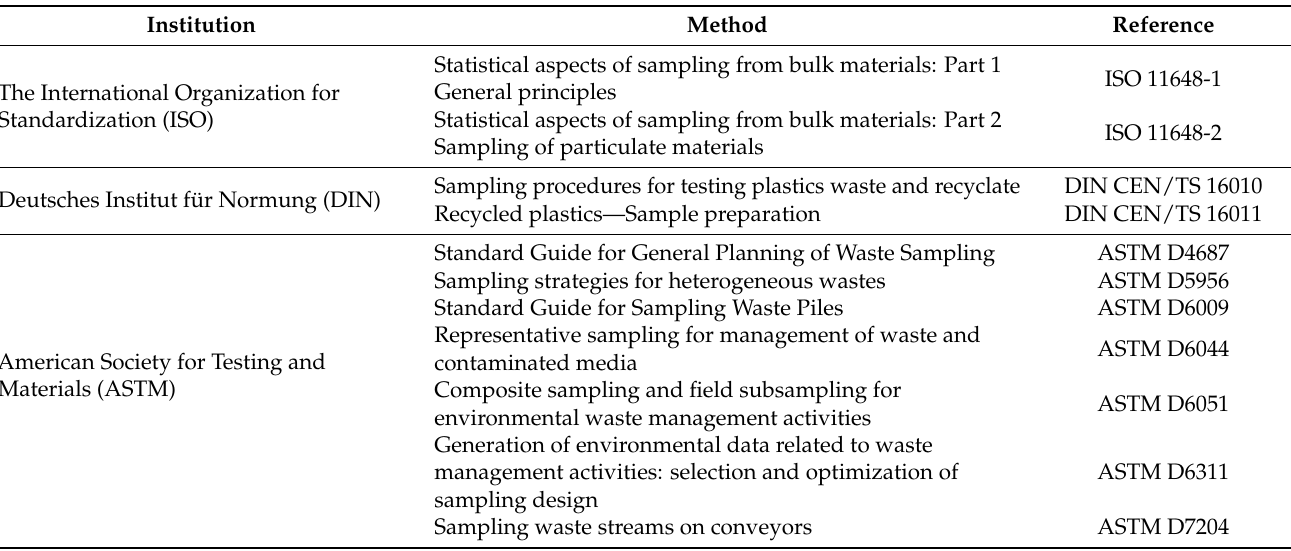
Table 1. Relevant standardized methods for the sampling of plastic waste (compiled by